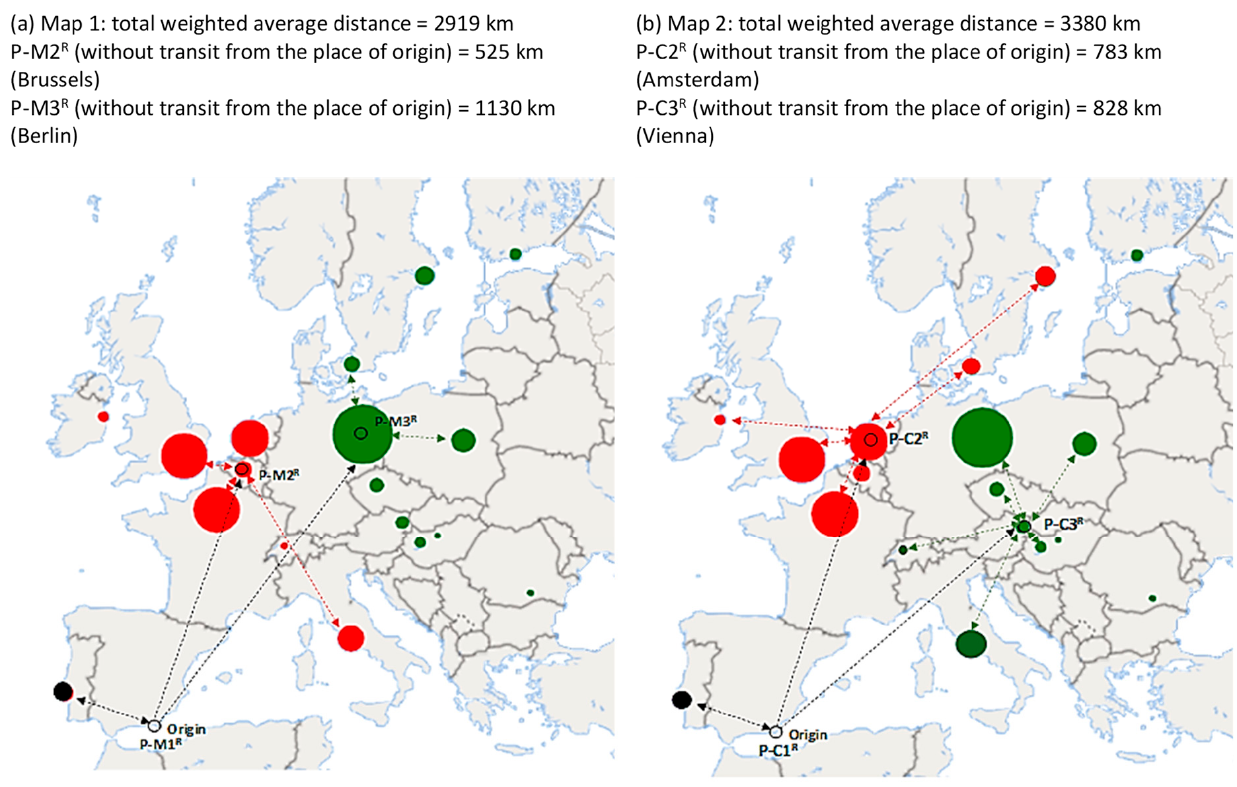
Figure 7. Results of the p-median (map a ) and p-center models (map b ) with random distances ( p = 3). Lines: only samples of routes are shown. Each color represents the customer allocation by redistribution center. Source: own elaboration.